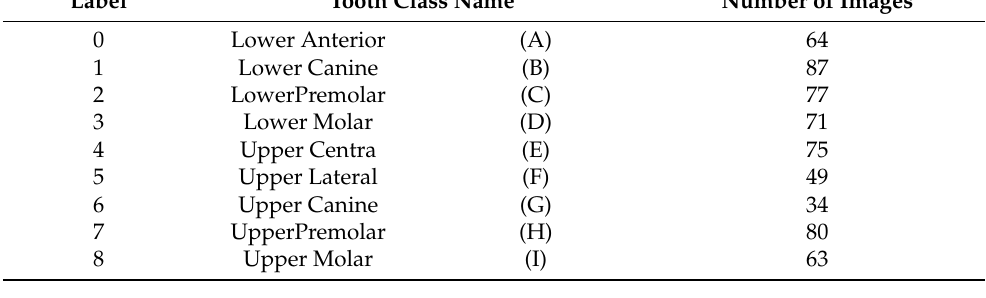
Table 1. Tooth classification and number of samples.